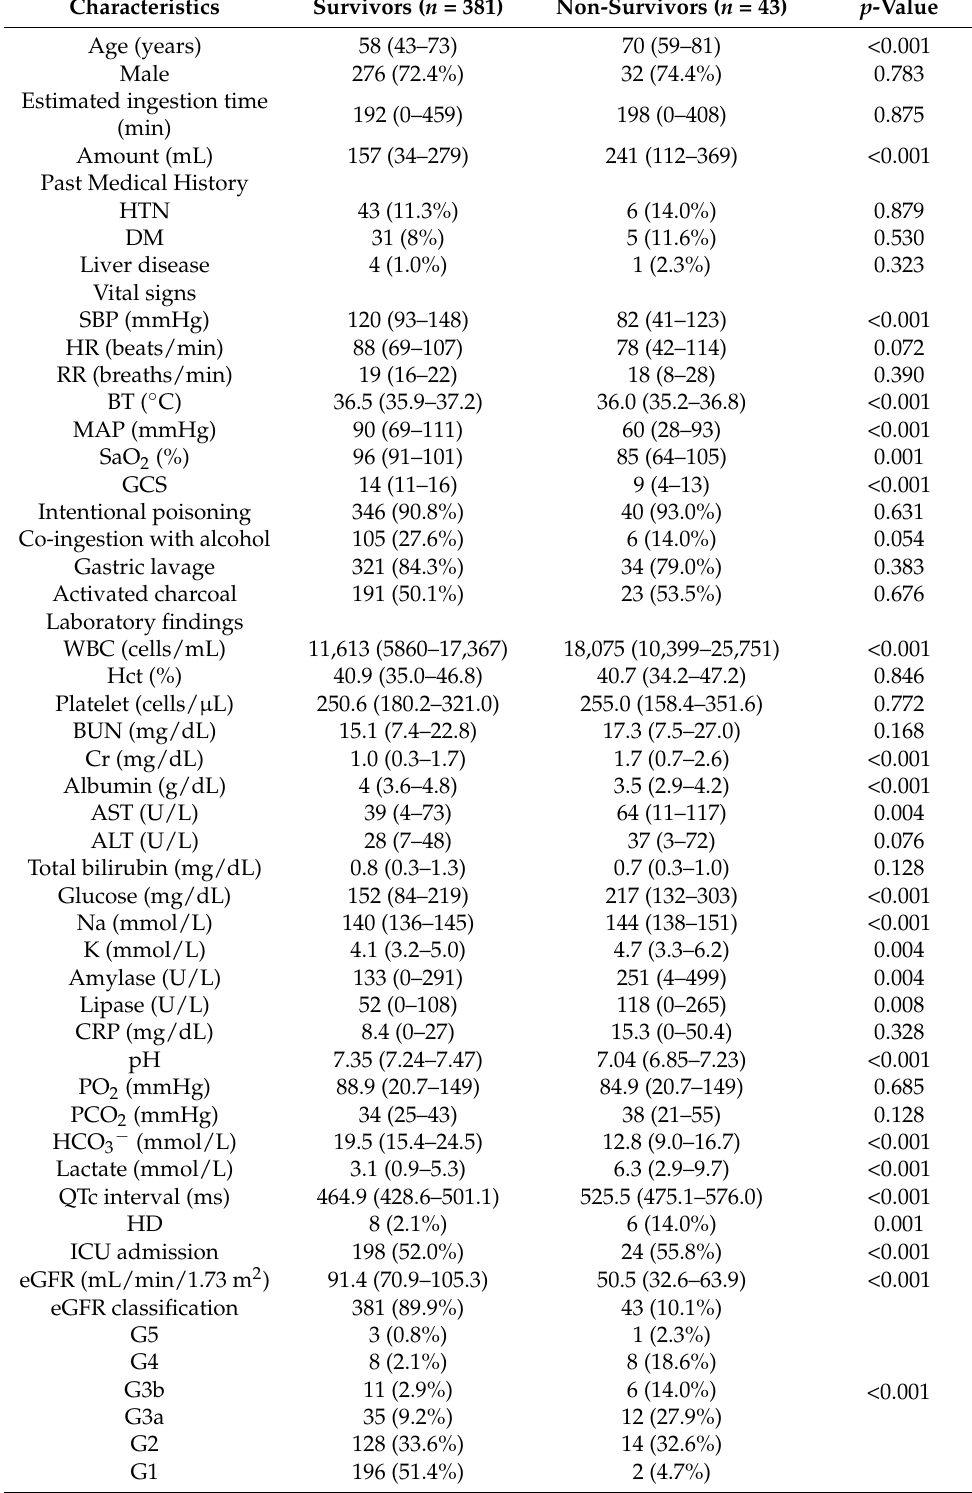
Table 1. Characteristics and laboratory findings of glyphosate-poisoned patients with in-hospital